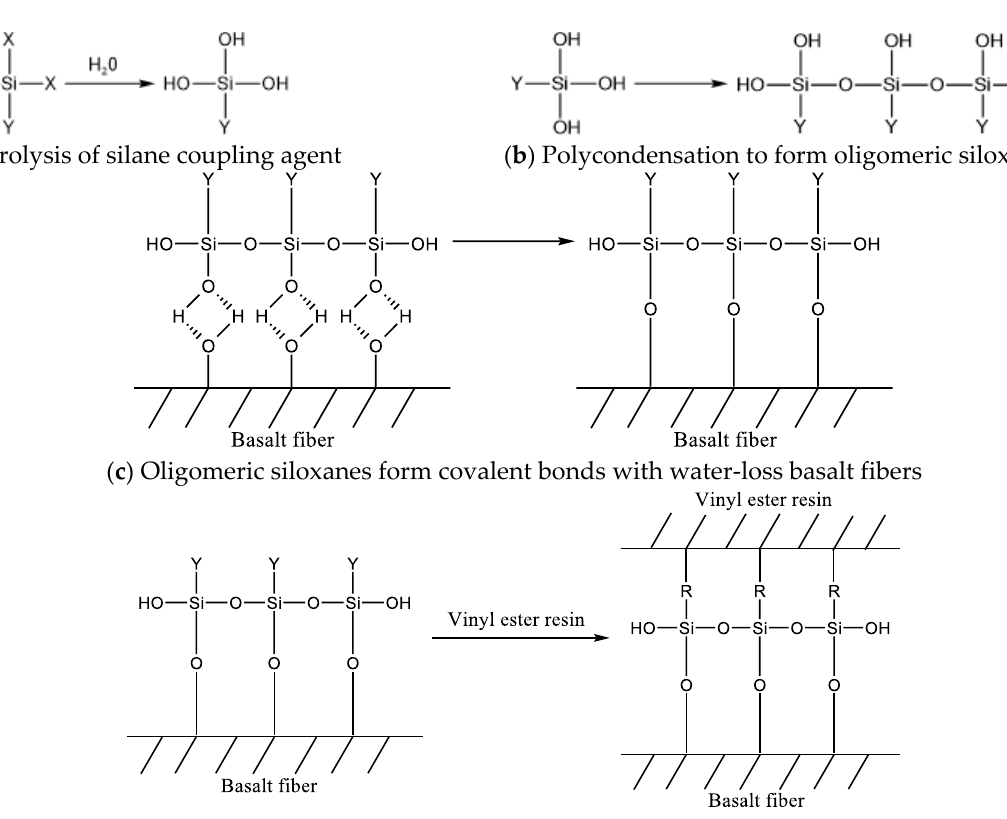
Figure 5. Cross-sectional view of BFRPs modified with different types of silane coupling agents.